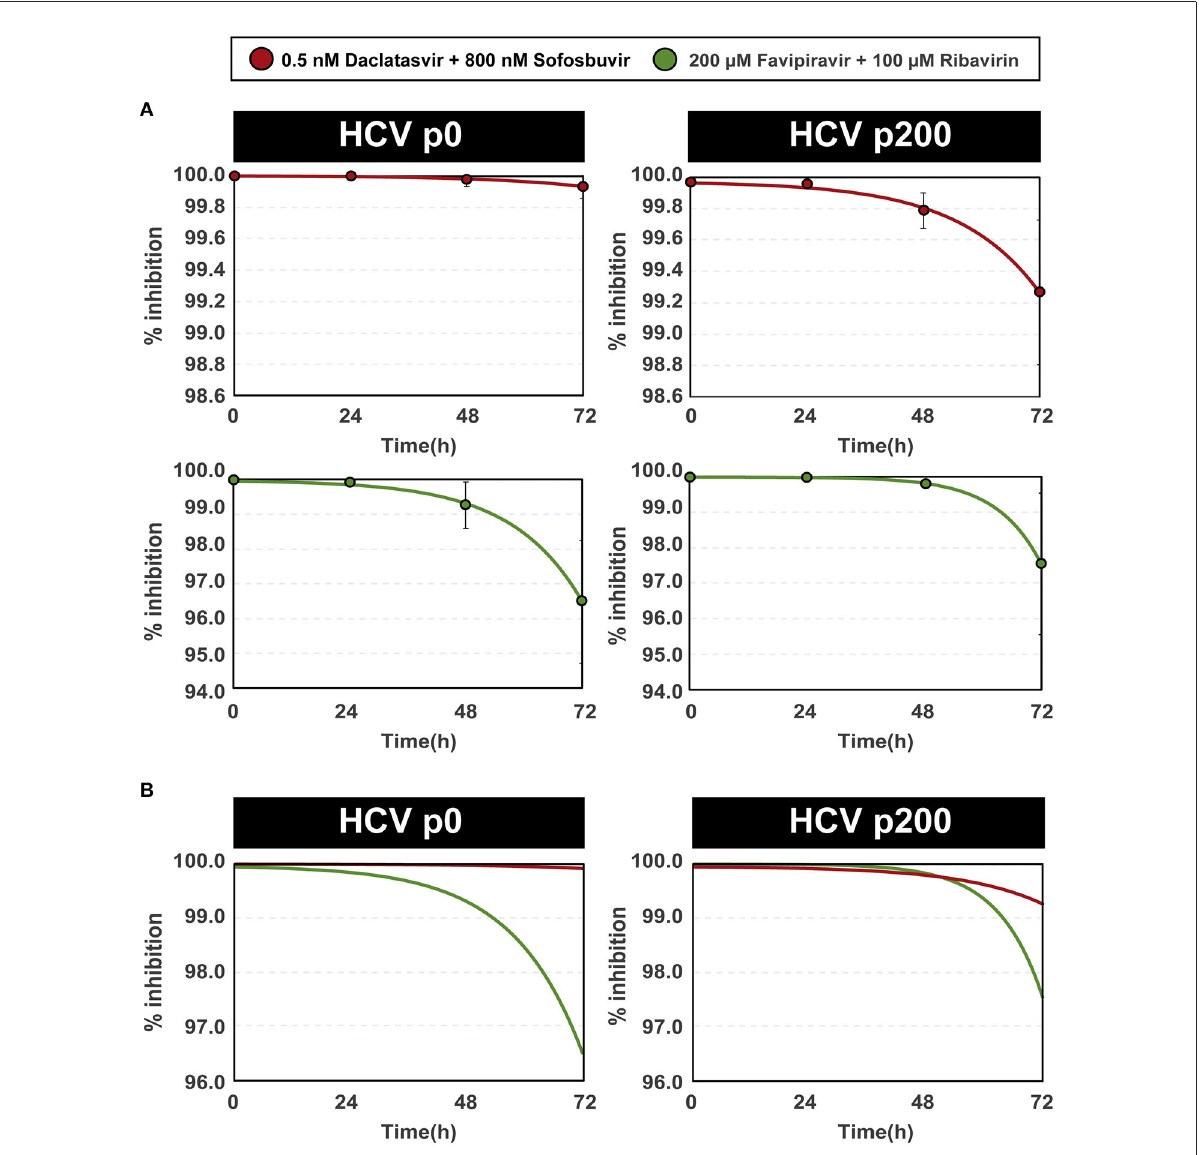
FIGURE2 Percentage of inhibition of HCV progeny production as a function of the time of inhibitor addition after initiation of infection. (A) The percentages of inhibition have been calculated with the data given in Figure 1 and Supplemental Table S2. The inhibitors (color coded) and HCV used are indicated in the upper boxes. The abscissae give the time elapsed between the initiation of the infection and the addition of inhibitors. The experimental points are given in the four panels, and the lines indicate the function that best fits the data. Note that the scale in ordinate differs among panels of the same column. The functions are the following: DAAs with HCV p0 (upper left panel): y = 100.00-(5.68 · 10 − 4 e (x / 0.84) ); DAAs with HCV p200 (upper right panel): y = 99.97-(2.21 · 10 − 3 e (x / 0.69) ); mutagens with HCV p0 (bottom left panel): y = 99.97-(4.69 · 10 − 3 e (x / 0.60) ); mutagens with HCV p200 (bottom right panel): y = 100.00-(6.33 · 10 − 5 e (x / 0.38) ). (B) For comparative purposes, the four adjusted functions [color coded as in (A)] are depicted with the same scale in ordinate. Procedures are detailed in Materials and Methods.